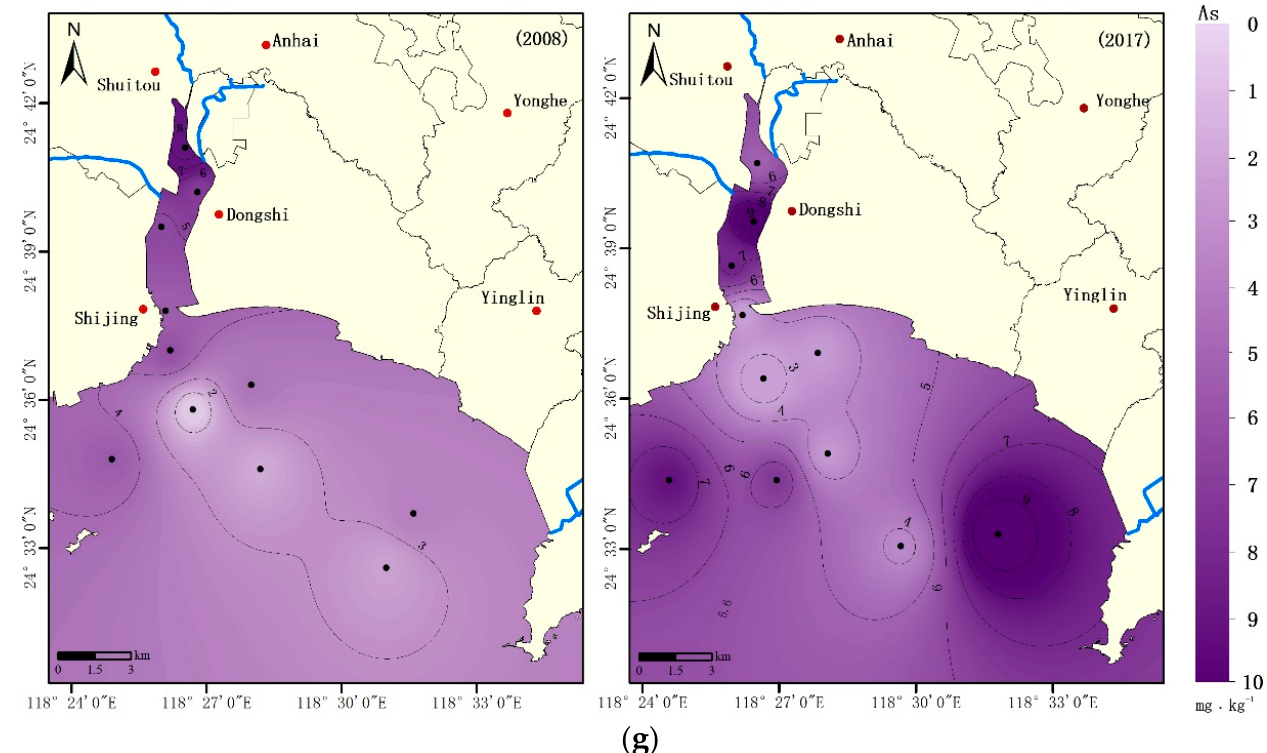
Figure 3. Spatial distributions of the heavy metals ( a ) Cu, ( b ) Pb, ( c ) Zn, ( d ) Cd, ( e ) Cr, ( f ) Hg, and ( g ) As concentrations in Weitou Bay surface sediment.